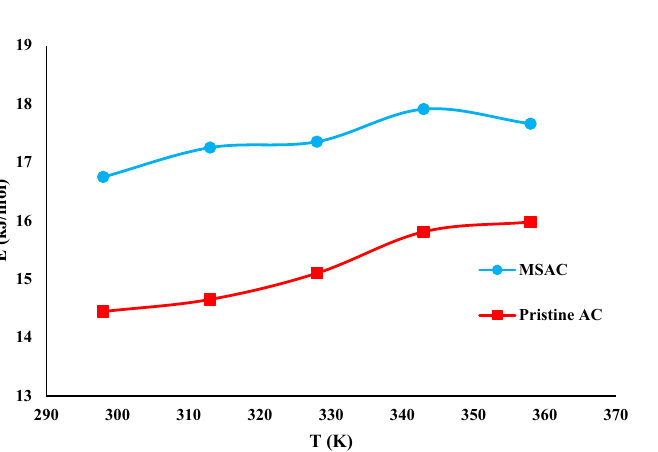
Figure 11. Influence of temperature on adsorbed quantity at saturation for MSAC and pristine activated carbon.